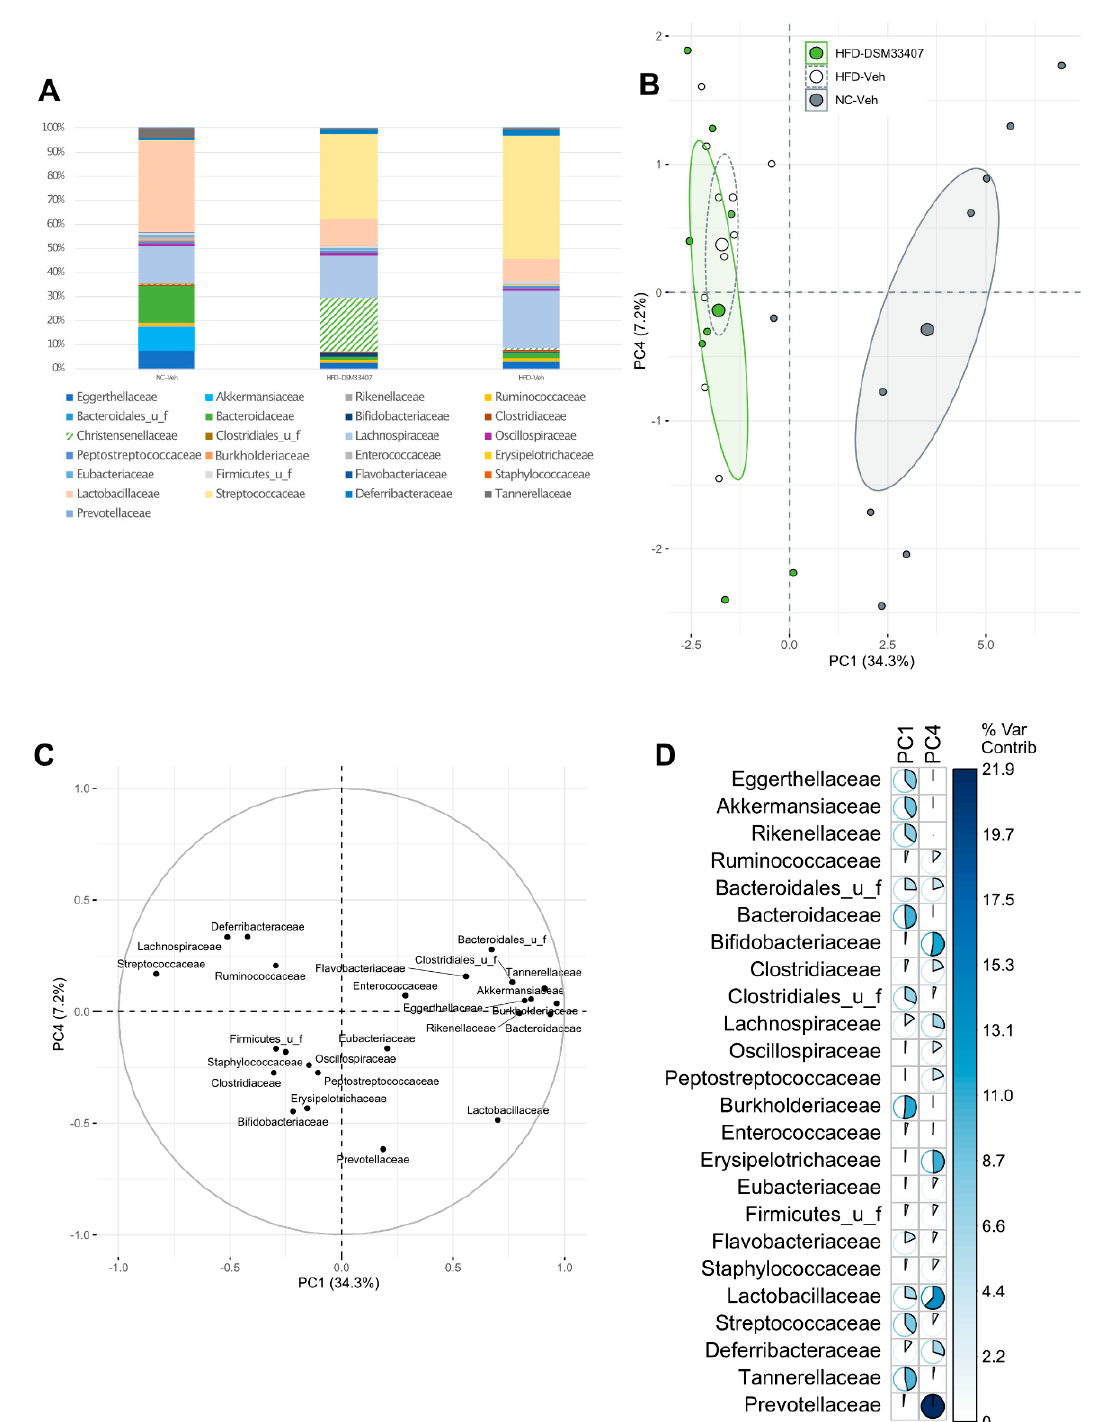
Figure 3. C. minuta DSM33407 modulated the fecal microbiome in a DIO mouse model assessed after 40 days of oral treatment (min n = 8). ( A ) Microbiome profile assessed using shotgun metagenomic profiling and displayed in a normalized stacked bar plot at the family level. ( B ) PCA analysis scores calculated from the dataset after removal of the Christensenellaceae family. The larger dot represents the group mean point surrounded by the 95% confidence ellipse. ( C ) PCA loadings plot and ( D ) associated variable contributions. The colored bar is scaled to the maximum percentage of contribution.